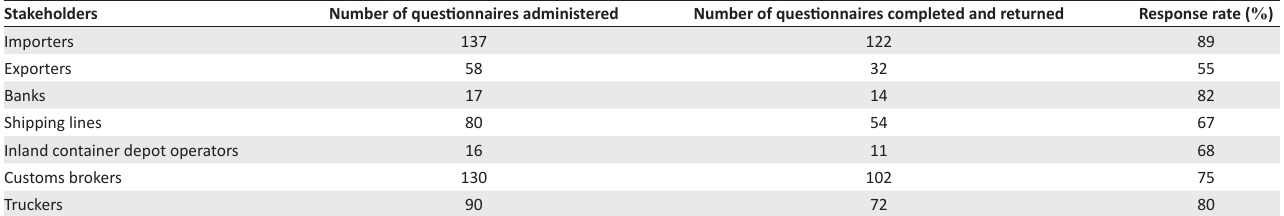
TABLE 2-A1: Summary of questionnaire administration and response